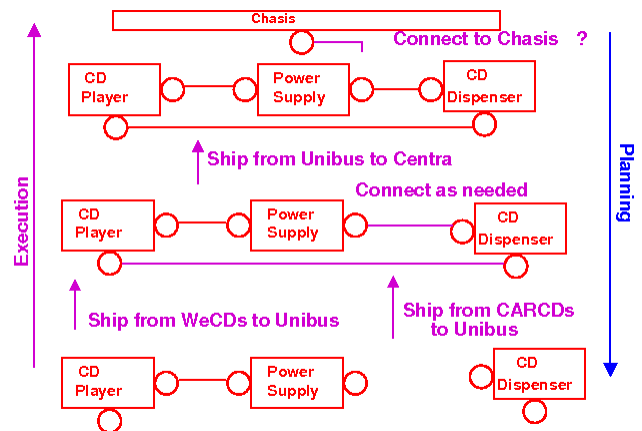
Figure 1. Workflow